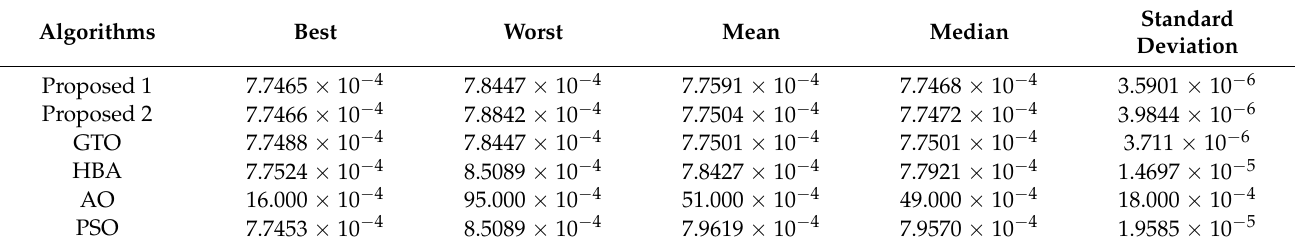
Table 7. Comparison of the statistical results.